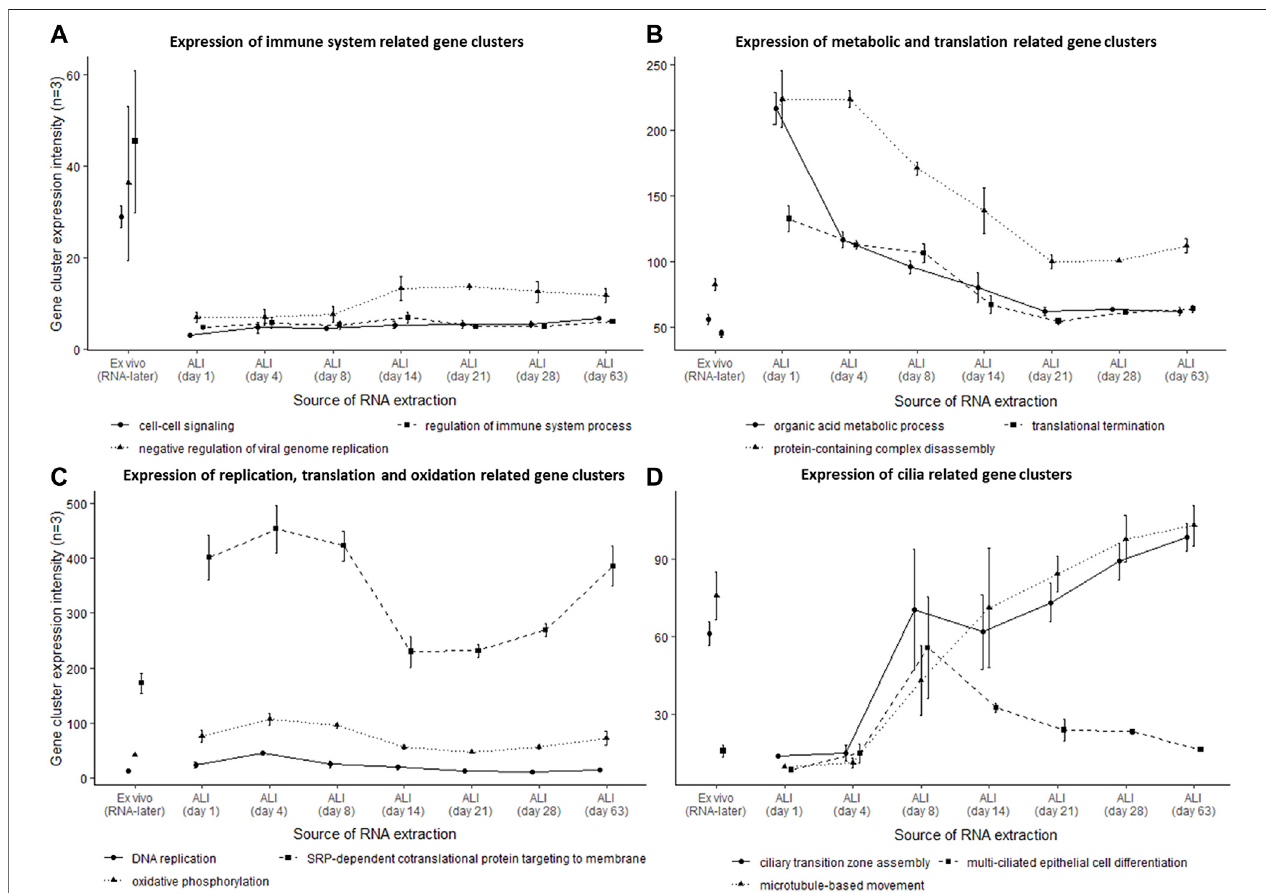
FIGURE 3 | Temporal changes of distinct gene clusters associated with a wide range of biological processes. Gene co-expression identi fi ed temporal changes of several distinct gene clusters. (A) Gene clusters associated with the “ regulation of immune process response ” (FDR p -value 1.59 × 10 -63 ), “ cell-cell signalling ” (FDR p - value 2.52 × 10 -03 ) and negative regulation of viral genome replication ” (FDR p -value 9.61 × 10 -03 ) being substantially higher in the ex vivo nasal epithelial cells stored in RNA-later ® . (B) While several gene clusters associated with “ organic acid metabolic processes ” (FDR p -value 17.96 × 10 -12 ), “ translational termination ” (FDR p - value 4.62 × 10 -05 ) and “ protein-containing complex disassembly ” (FDR p -value 2.60 × 10 -04 ) were more prominently expressed at in vitro ALI-culture day 1, with the expression declining in the subsequent ALI-culture time-points. (C) Gene clusters associated with “ DNA replication ” (FDR p -value 2.52 × 10 -38 ), “ SRP-dependent cotranslational protein targeting to membrane ” (FDR p -value 3.28 × 10 -29 ) and “ oxidative phosphorylation ” (FDR p -value 2.47 × 10 -09 ) were highly expressed at ALI- cultureday4,and appeared tobecomecyclicover thesubsequent ALI-culturetime-points. (D) Finally,ageneclusterinvolved “ multi-ciliated epithelialcelldifferentiation ” (FDR p -value 1.28 × 10 -04 ) was highly expressed at ALI-culture day 8, and other gene clusters involved with ciliogenesis being “ ciliary transition zone assembly ” (FDR p - value 2.74 × 10 -09 ) and “ microtubule-based movement ” (FDR p -value 1.31 × 10 -105 ) were being substantially expressed from ALI-culture day 8 onwards. Three healthy donors were used for each